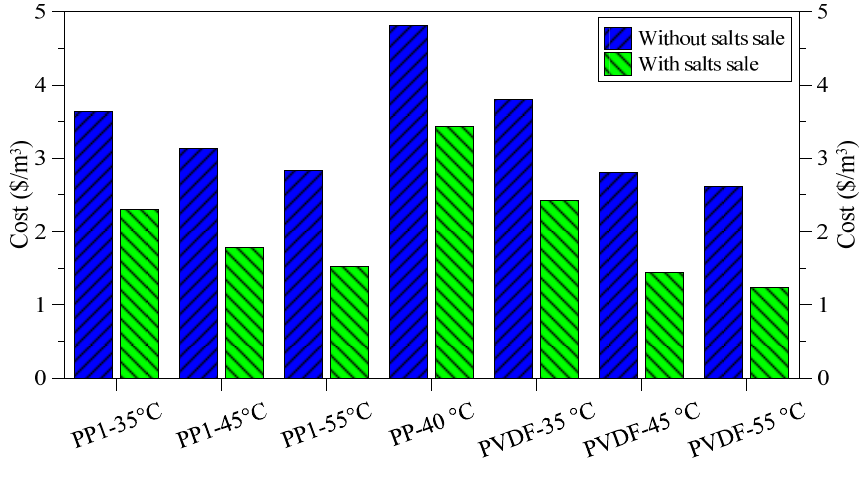
Figure 14. Treatment cost for various operating conditions and membranes